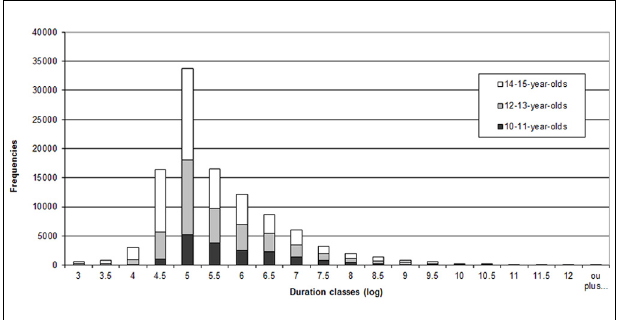
FIGURE 1 | Pause distribution (log transformed) for all draft